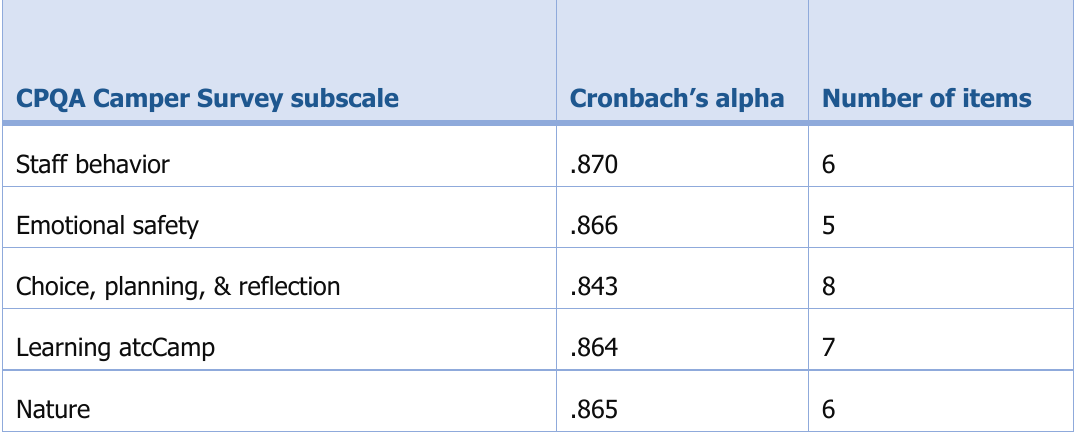
Table 2. Reliability of Survey